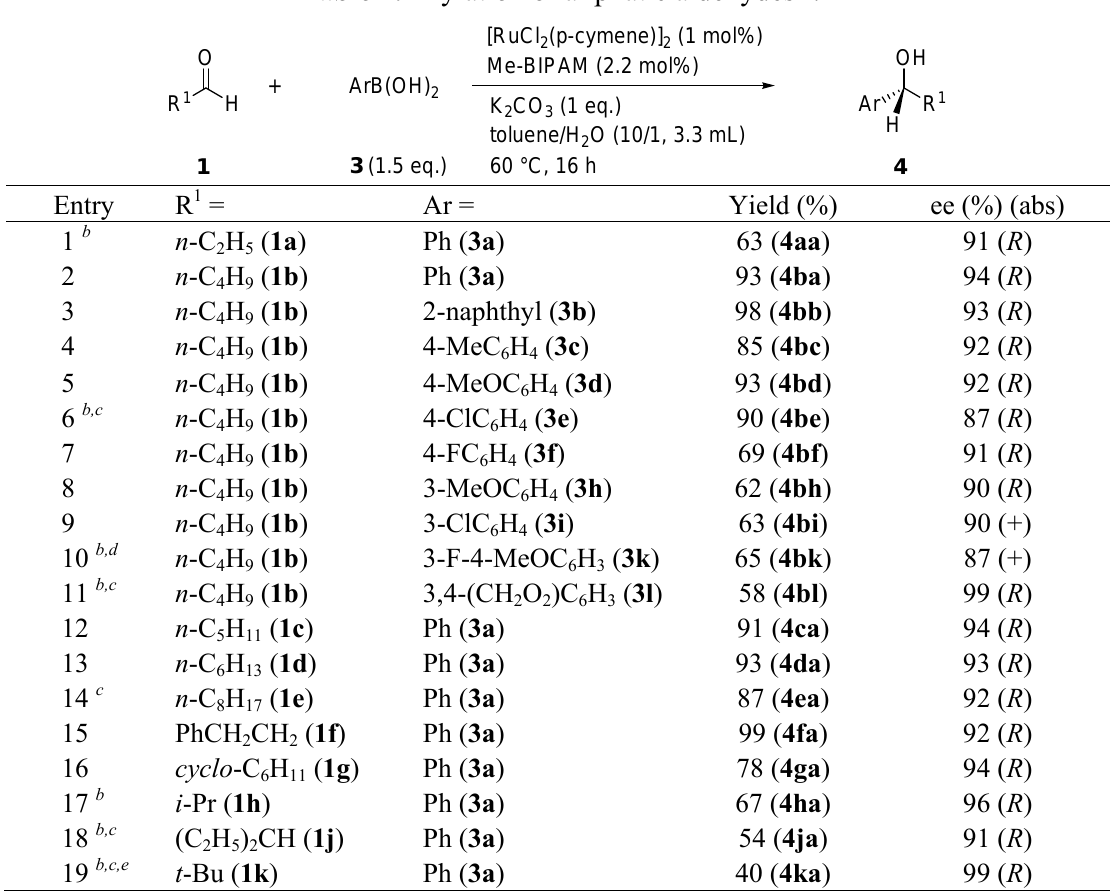
Table 1. Arylation of aliphatic aldehydes a .